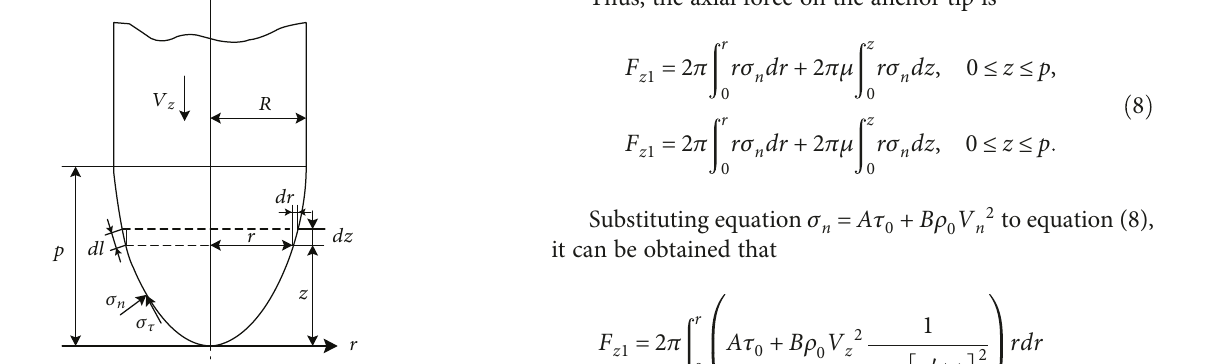
Figure 9: Force on the anchor tip with arbitrary